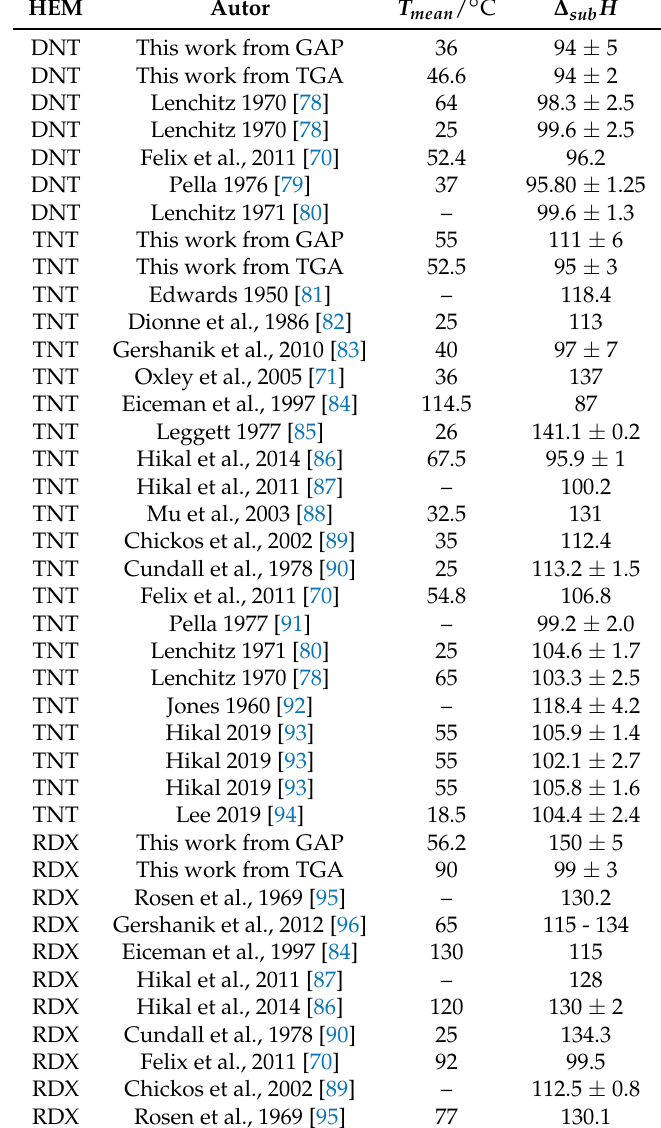
Table 4. Enthalpies of sublimation for DNT, TNT, and RDX in this study and the in literature. HEM